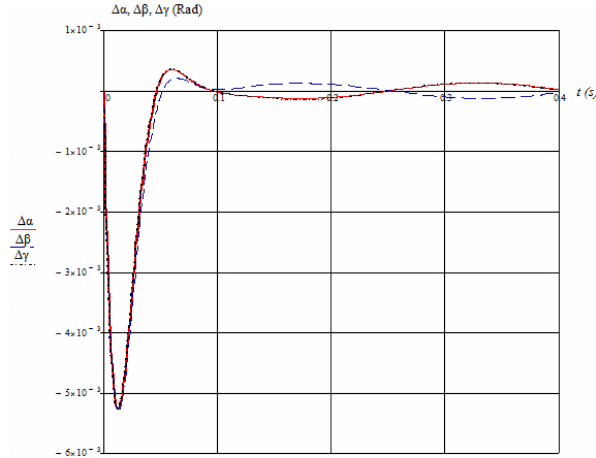
Figure 6. Graph of the changes in the position error (cid:49)α , (cid:49)β , and (cid:49)γ of the output